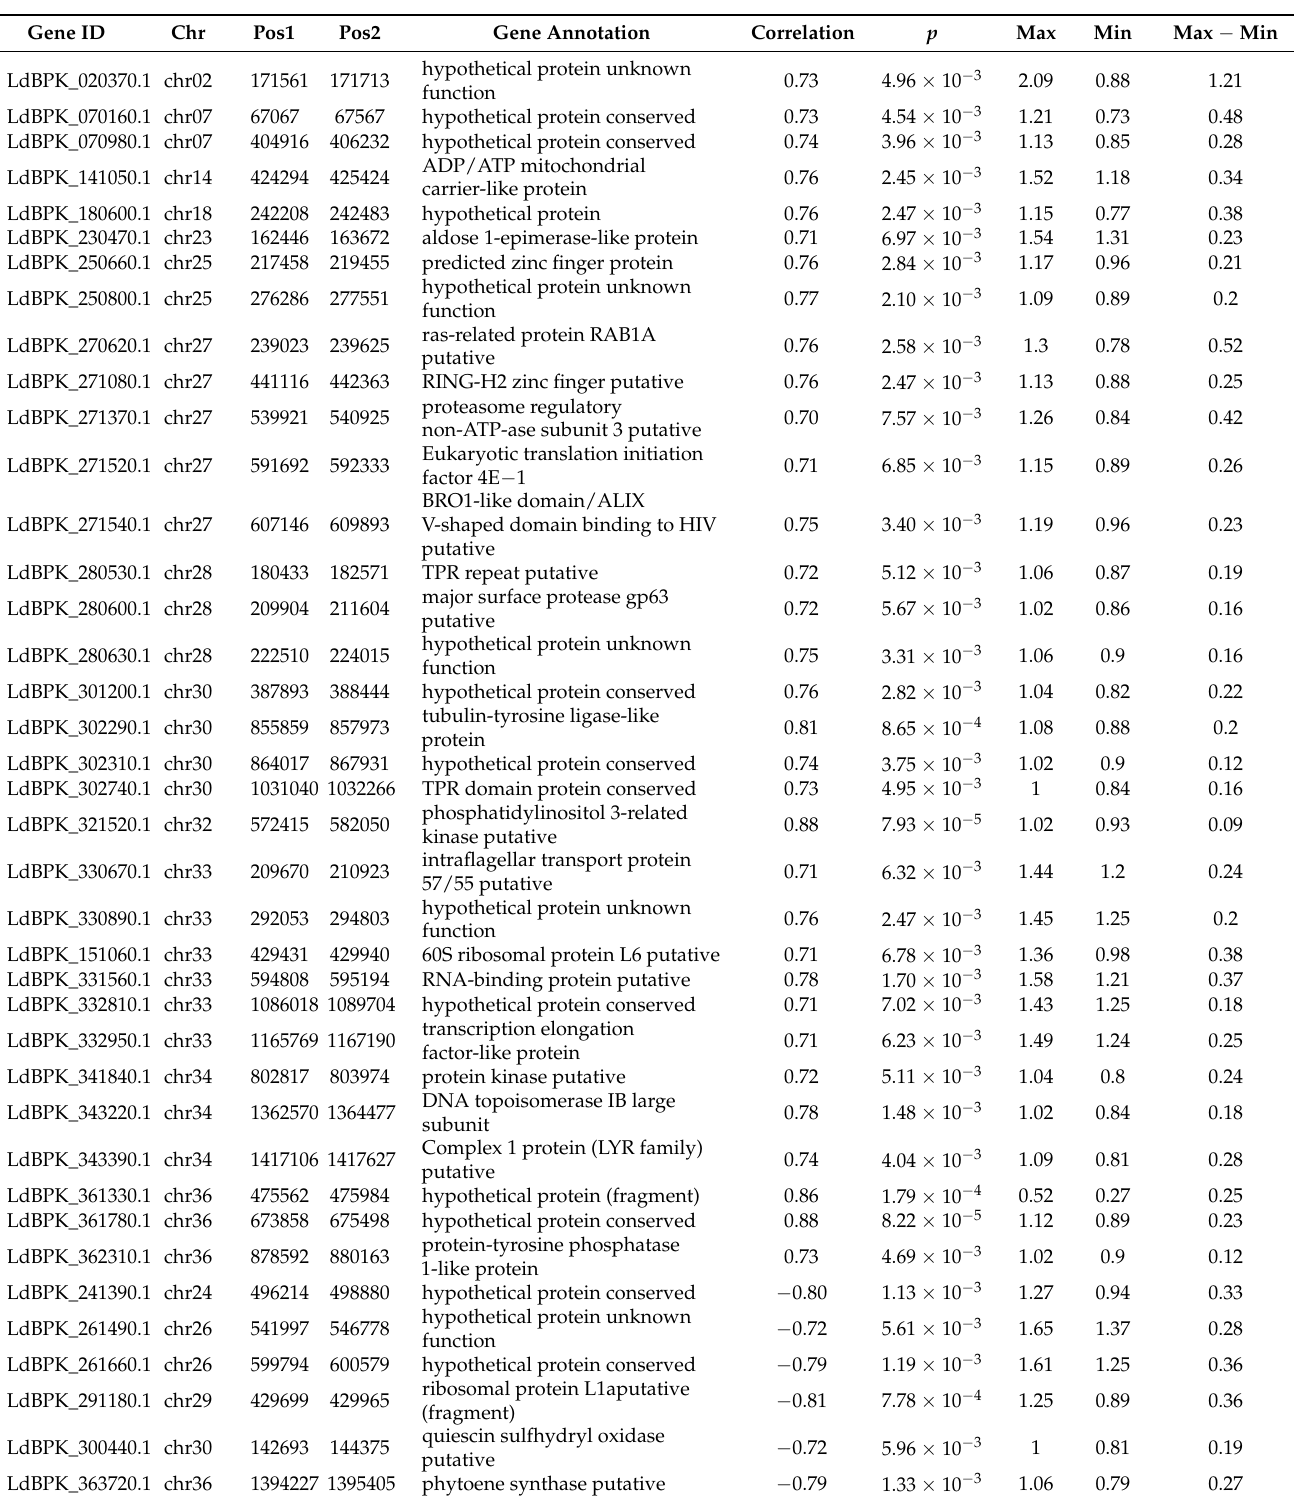
Table 2. Genes potentially associated with PMM resistance. Correlation between gene copy number and PMM resistance. Only genes for which the correlation, r, was ≥ 0.7 or ≤− 0.7 and the correlation p -values were lower than 0.05 are reported. GeneID: TriTrypDB L donovani gene ID; Chr: chromosome number; Pos 1: gene initial coordinate; Pos 2: gene final coordinate; Correlation: Gene CN and PMM resistance correlation; p : Correlation p -value; Max: Maximum gene CN in all clone/population; Min: Minimum gene CN in all clone/population; Max–Min: the difference between the Max and Min gene CNV